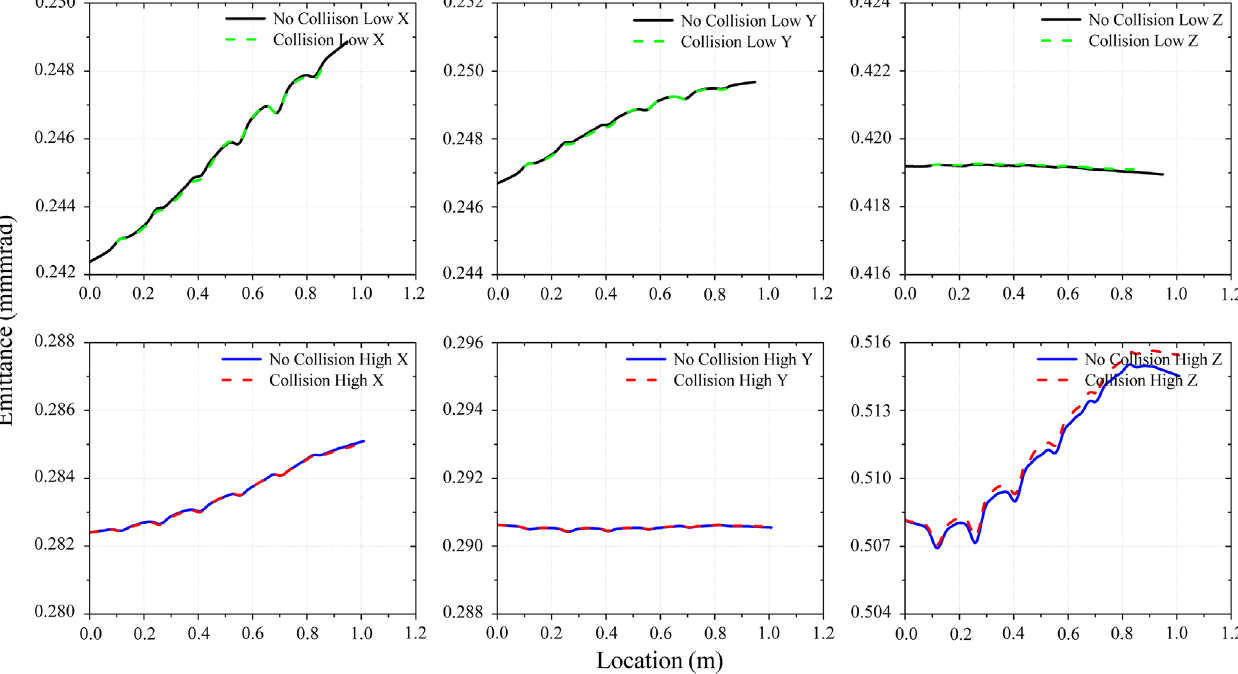
FIG. 6. The rms emittance evolution from the single-bunch simulation and the combined two -bunch simulation in the first cavity collision region.